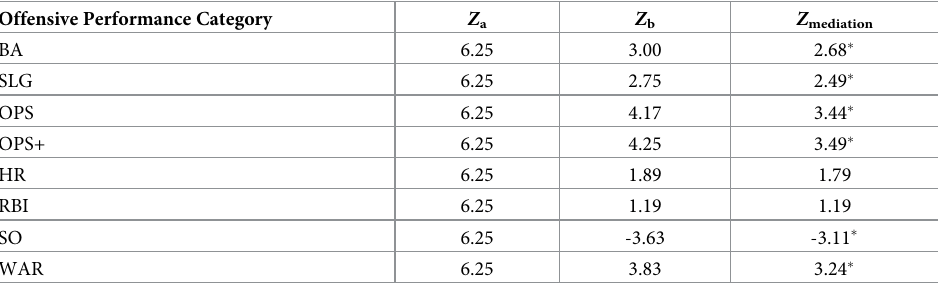
Table 4. Mediation analyses of birthplace (Canada vs. World) on offensive performance through handedness ori- entation (bats left, throws right vs.